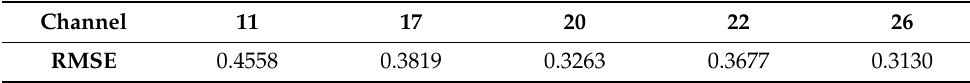
Table 2. RMSEs of the spatial distribution model of PRR under different